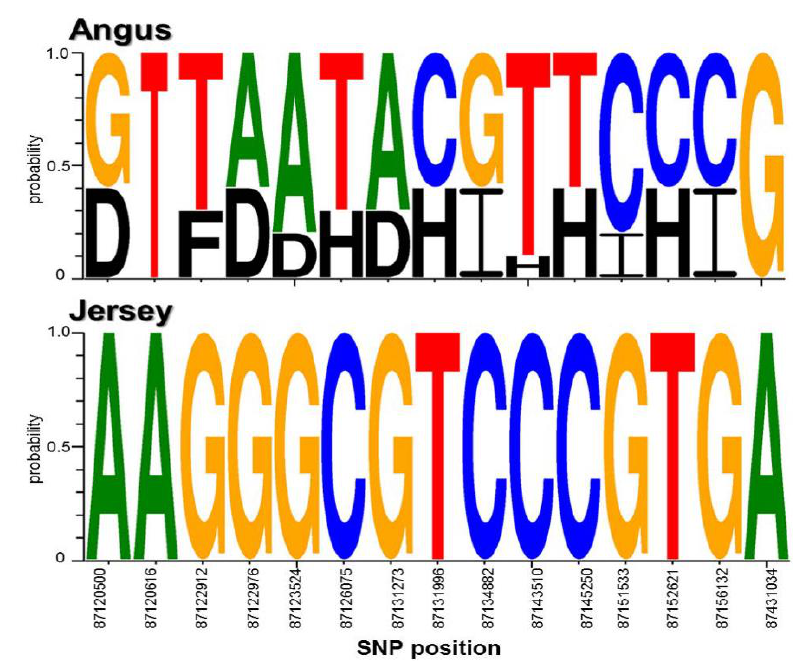
Figure 4. Genotypic profiles of the identified casein genes in Angus and Jersey. This is the genotype profiles of the SNPs in CSN1S1 and CSN3 in Angus and Jersey breeds. A, T, G, C, B, D, E, F, H, and I in the figure indicate AA, TT, GG, CC, AT/TA, AG/GA, AC/CA, TG/GT, TC/CT, and GC/CG genotypes, respectively.